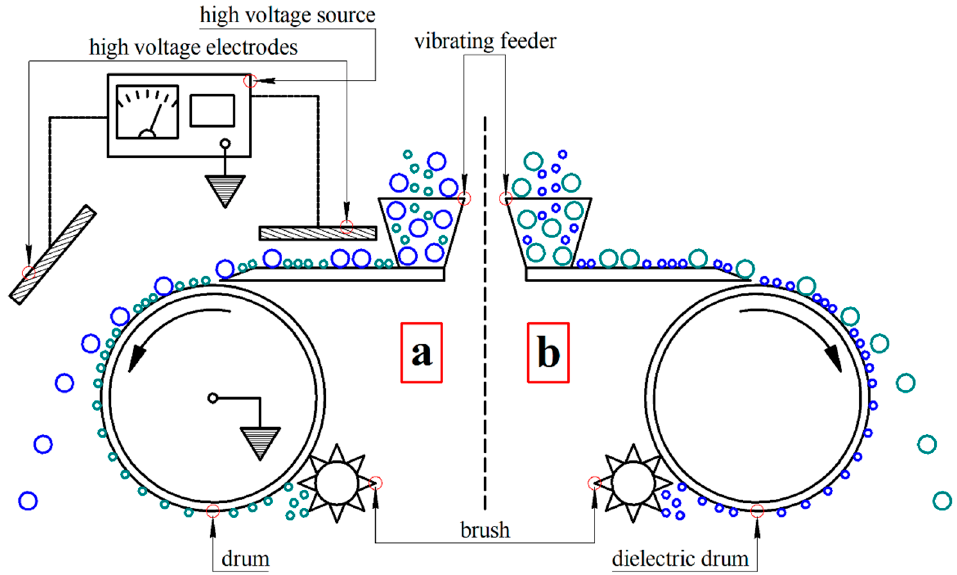
Figure 2. Separator schemes: ( a ) ELKOR electrostatic drum separator; ( b ) Zeus centrifugal drum separator.